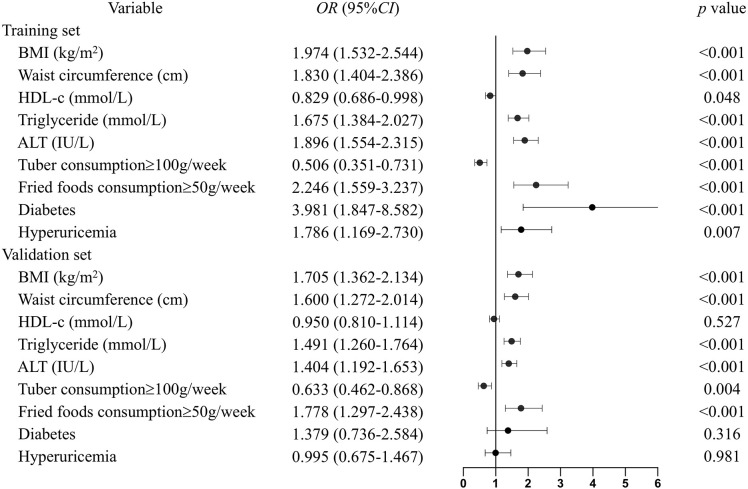
Multivariable odd ratios for the relationship between the eight identified risk factors and NAFLD. Continuous variables were subsequently classified by quartiles, and the first quartile was used as the reference category. The following scores were assigned to the quartiles for BMI: 1, <20.5; 2, 20.5–22.4; 3, 22.4–24.6; and 4, >24.6 kg/m2. Waist circumference: 1, <74; 2, 74–80; 3, 80–87; and 4, >87 cm. HDL-c: 1, <1.17; 2, 1.17–1.36; 3, 1.36–1.46; and 4, >1.46 mmol/L. Triglyceride: 1, <0.88; 2, 0.88–1.15; 3, 1.15–1.62; and 4, >1.62 mmol/L. ALT: 1, <13; 2, 13–18; 3, 18–26; and 4, >26 IU/L. The groups were subdivided into subgroups based on tuber and fried food consumption, based on cutoff points of 100 g/weeks and 50 g/weeks, respectively. For diabetes and hyperuricemia: 1 means the presence of the diseases and 0 means not.